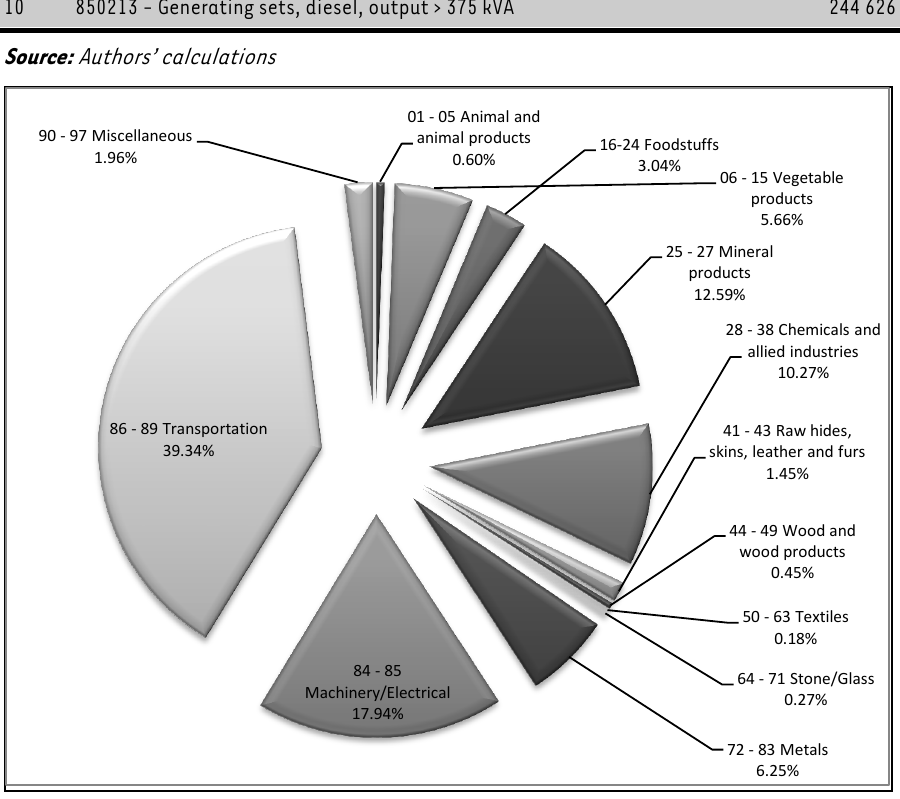
FIGURE 1: Comparison of potential export values (US$ thousand) of South Africa per HS 2-digit product group in South